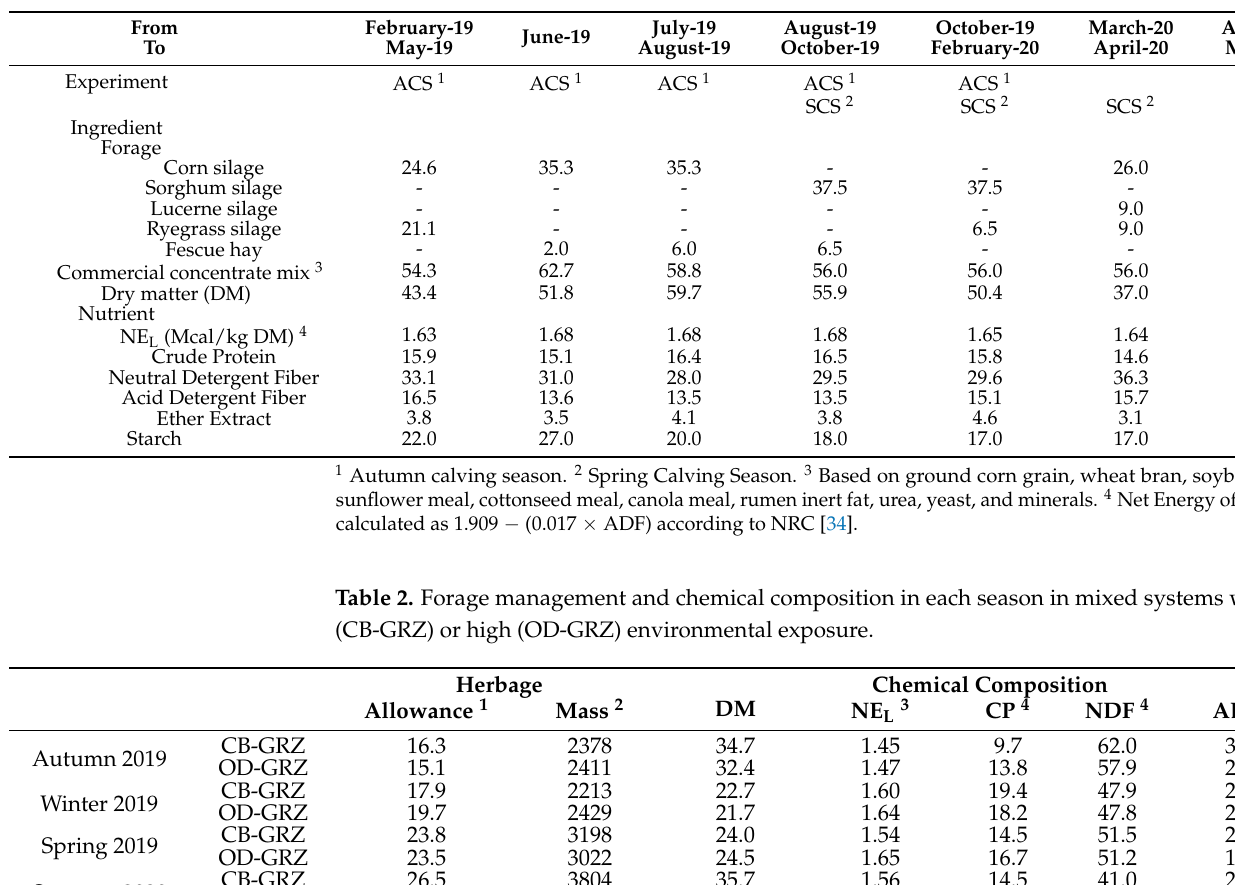
Table 1. Composition, chemical analysis, and nutritional value of mixed diets fed to lactating cows (% dry matter).